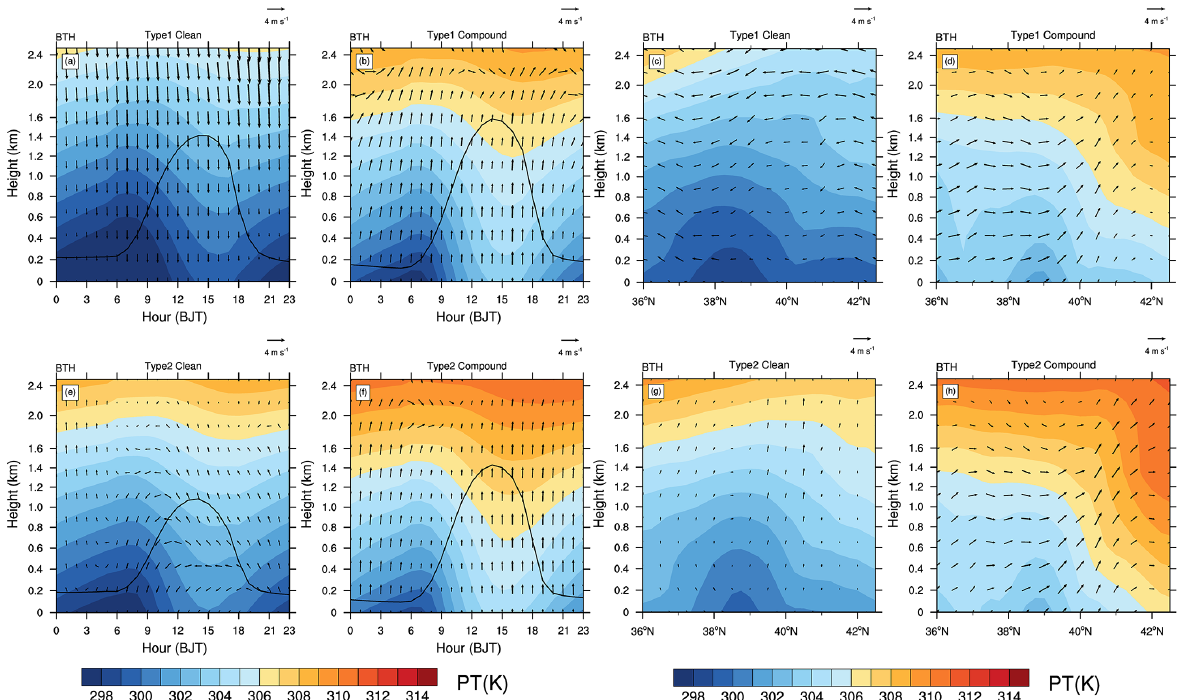
Figure 11. Daily variations of horizonal wind, potential temperature and BLH in the BTH area during clean and compound pollution periods under Type 1 and Type 2 (a, b, e, f) . The vertical cross section of u wind, w wind and potential temperature for the same situation in the BTH region (c, d, g, h) . The w wind is multiplied by 100 when used. The data are from ERA5 reanalysis.